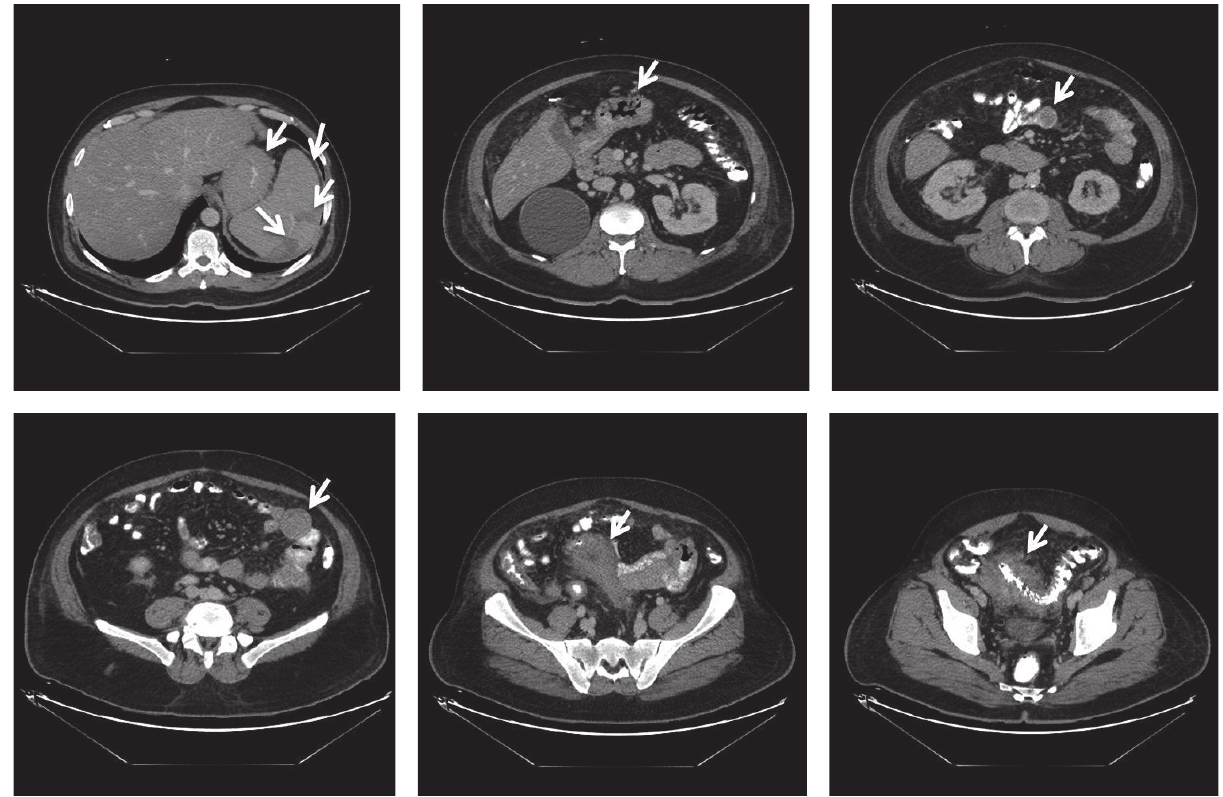
Figure 1: CT NCAP demonstrating a large soft tissue mass surrounding the sigmoid with mild enhancement measuring around 9.2 × 12 × 6 cm, multiple enhanced soft tissue masses surrounding multiple segments of the small bowel, multiple peritoneal implants, and multiple mesenteric subcentimetric lymph node enlargement. There were also circumferential stomach wall thickening measuring around 2.8 cm, small subcentimetric left axillary and periaortic lymph nodes, splenomegaly, and two splenic enhancing